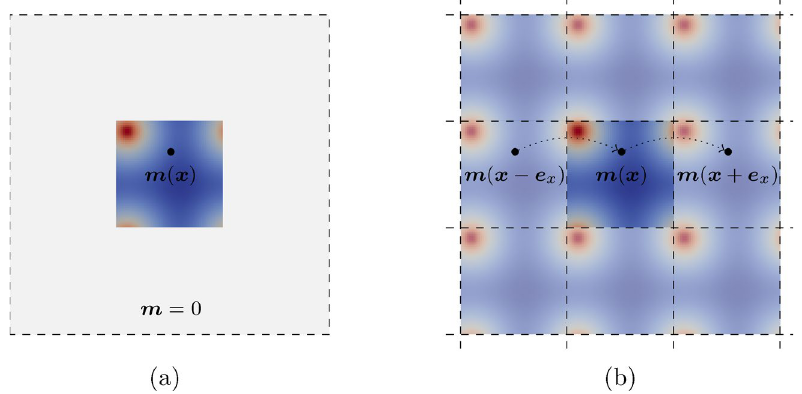
Figure 1. Magnetization configurations in case of ( a ) open-boundary conditions and ( b ) periodic boundary